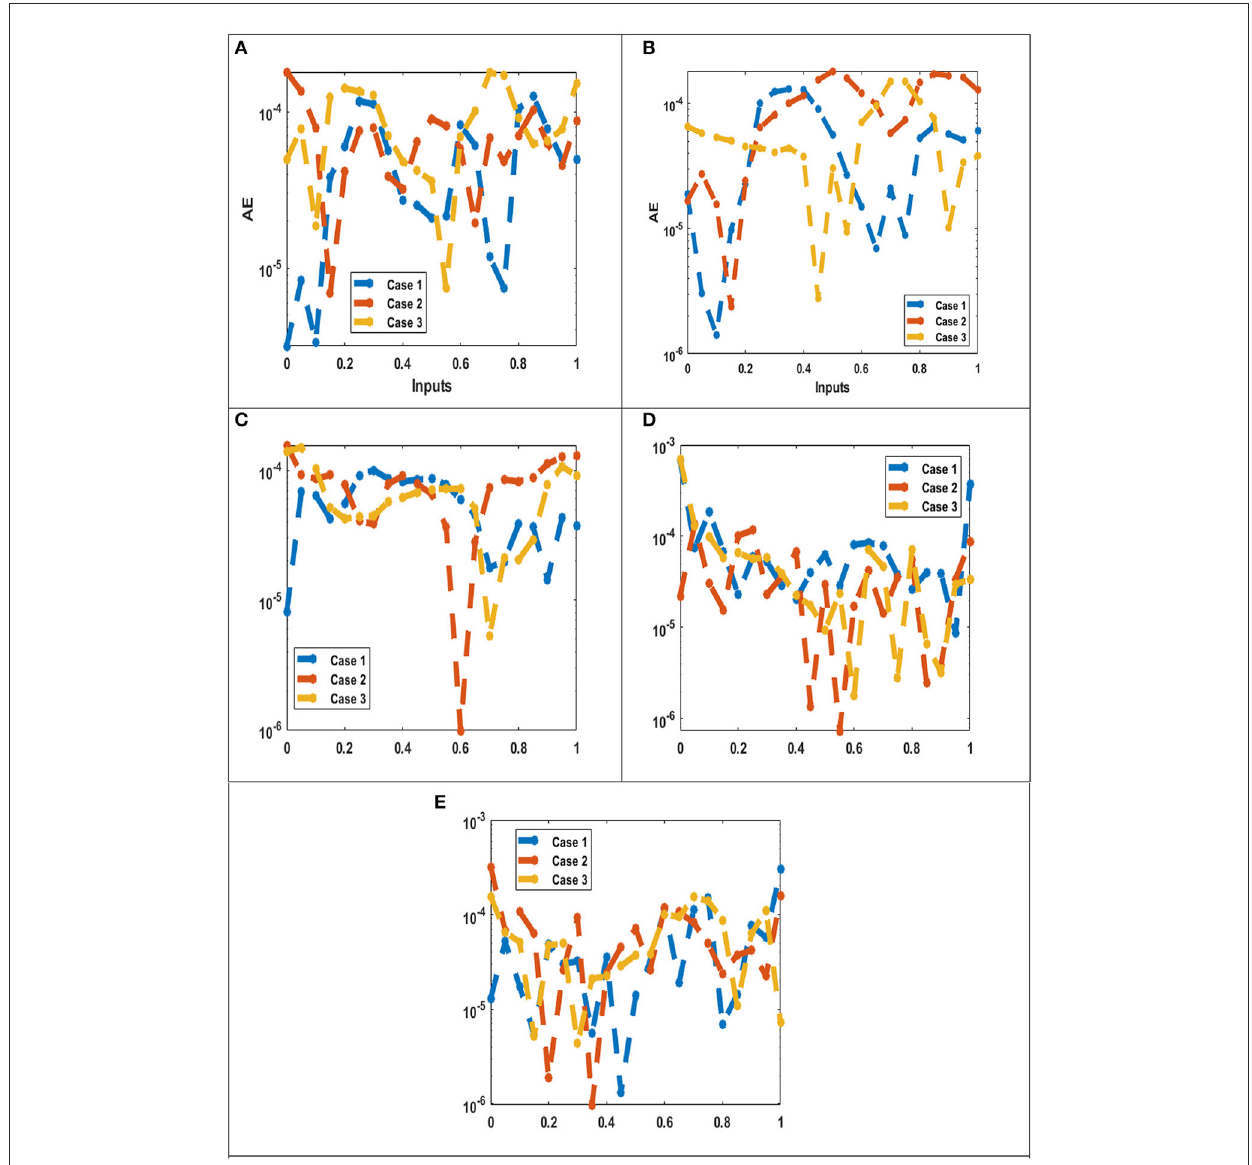
FIGURE11 AE for the performances of the integer order system. (A) AE: X ( t ). (B) AE: Y ( t ). (C) AE: W ( t ). (D) AE: R ( t ). (E) AE: Z ( t